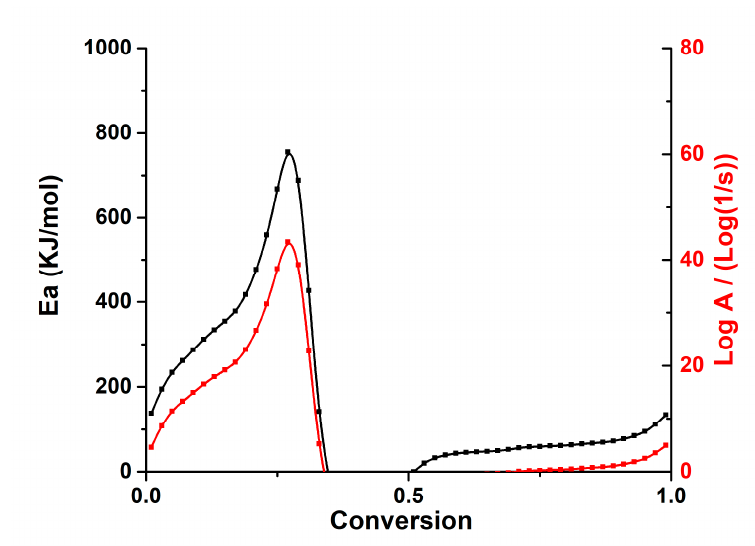
Figure 10. Activation energy (black) and pre-exponential factor (red) plot for PEEK under 2% oxygen, obtained by Friedman analysis.